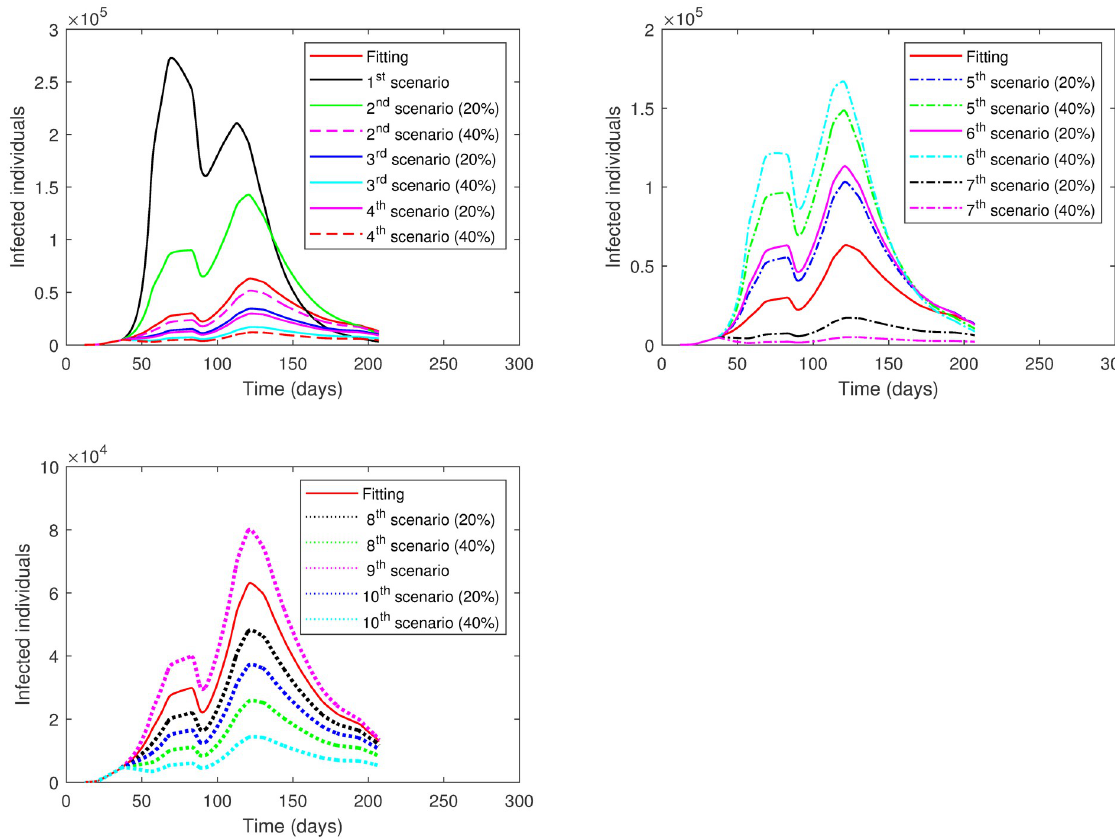
Fig 9. The numerical solution of model (1) for infected compartment vs. time with different scenarios of Phase 3 in the First Case: 1 st scenario, no lockdown is implemented; 2 nd scenario, no lockdown while SD increases; 3 rd scenario, lockdown increases; 4 th scenario, SD increases; 5 th scenario, lockdown decreases; 6 th scenario, SD decreases; 7 th scenario, lockdown and SD increases; 8 th scenario, lockdown decreases and SD increases; 9 th scenario, ρ is the same as in Phase 2; 10 th scenario, ρ is the same as in Phase 2 while SD